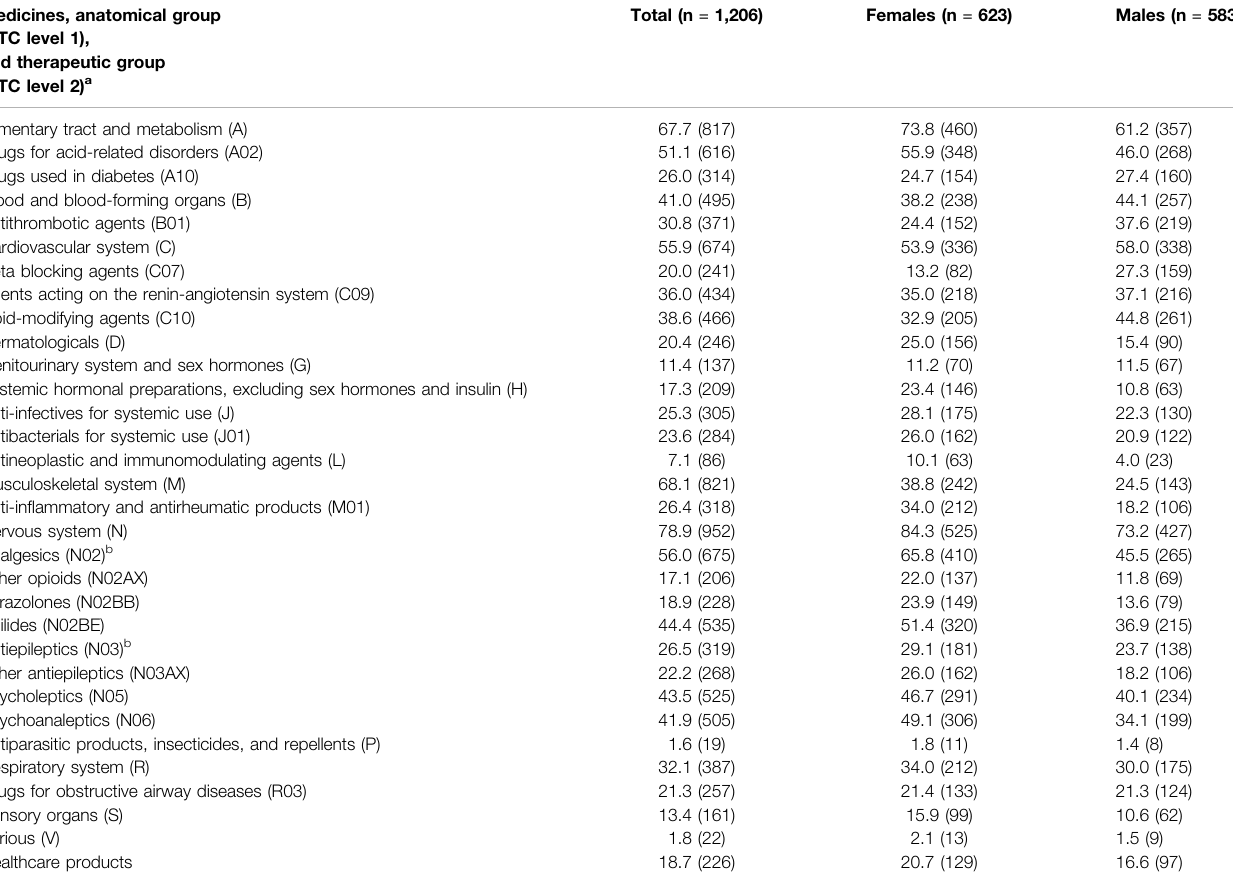
TABLE 2 | Proportion of bene fi ciaries that received at least one medicine or healthcare product overall and for gender, % (N). Medicines, anatomical group (ATC level